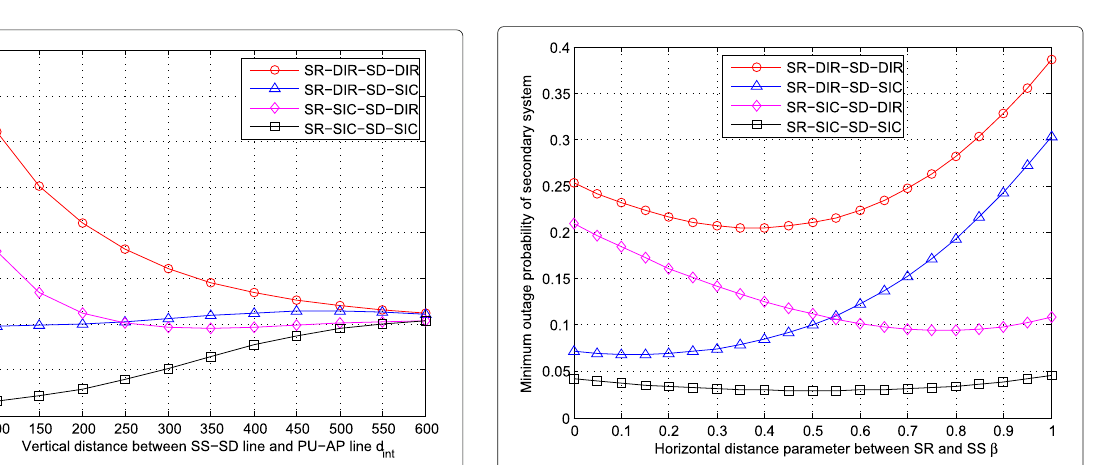
Fig. 13 Minimum outage probability of secondary system vs the distance factor